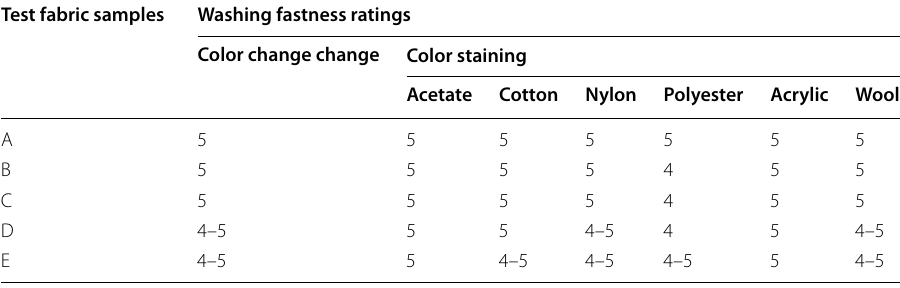
Table 3 Colorfastness to washing (color change and color staining) of henna dyed polyes- ter fabric